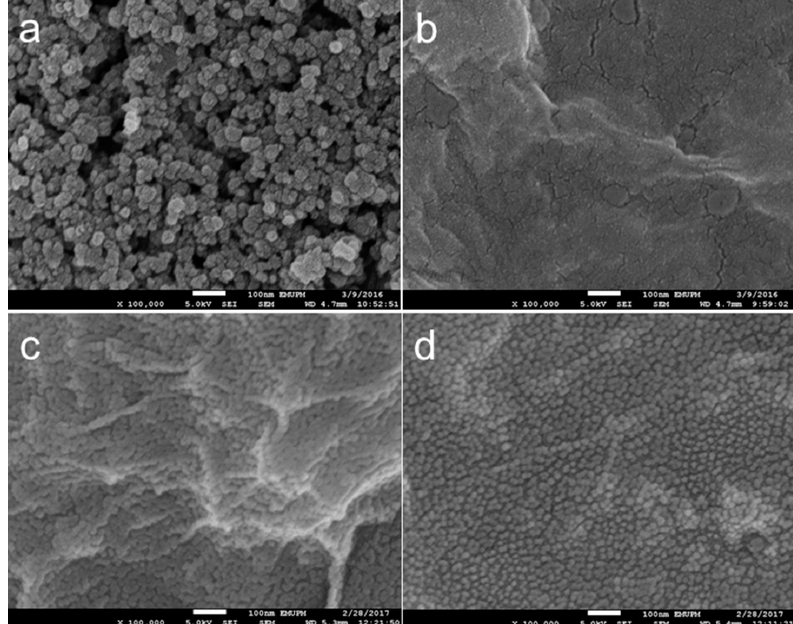
Figure 3. Field emission scanning electron microscope (FESEM) images of ( a ) bare SPCE; ( b ) SPCE/PEDOT/GO; ( c ) SPCE/PEDOT/GO/Ab; and, ( d ) SPCE/PEDOT/GO/Ab-CLB.